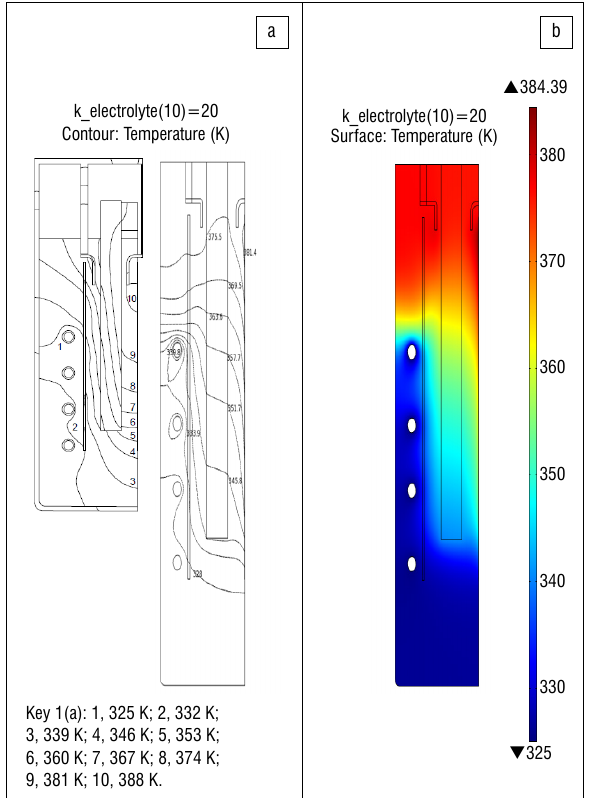
Figure 2: (a) Mean hydrogen gas distribution for two different current densities, low on the left and high on the right, reproduced from Roustan et al. 9 (b) Our simulation of the published electrolyser of Roustan et al. 9 , showing relative gas